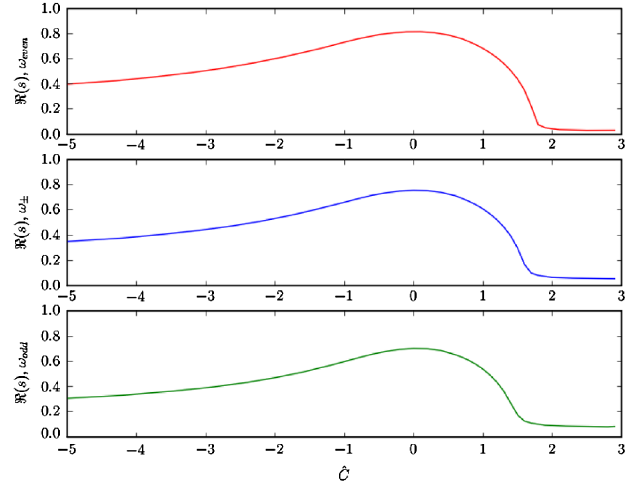
FIG. 2. Growth rates for three eigenmodes: (i) the top shows a mode with largest eigenvalue, (ii) the middle shows the degen- erate case of the odd/even mixtures, (iii) the bottom shows smallest